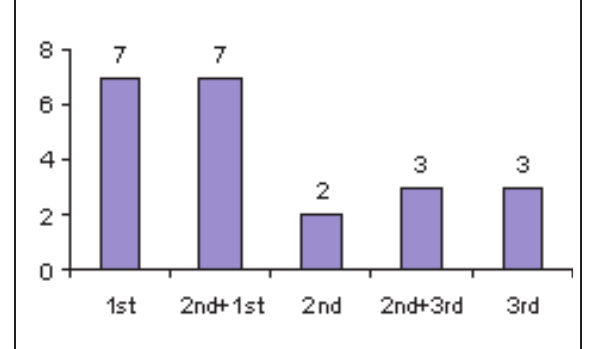
Fig. 2: Degree of Burn.